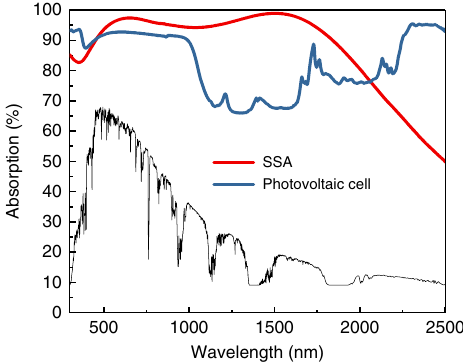
Fig. 2 UV-Vis-NIR spectra of the solar cell and the spectrally selective absorber (SSA) material. (The standard solar radiation spectra of air mass 1.5 global (AM 1.5G) is shown by the black